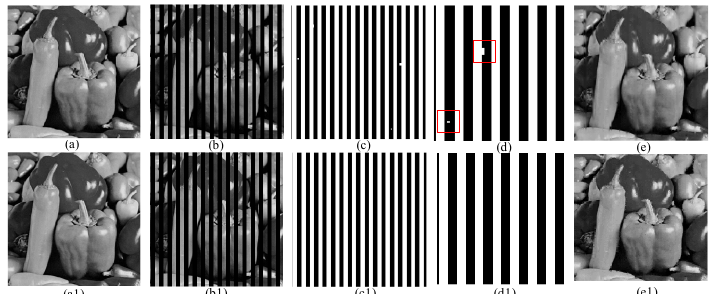
Figure 13. Longitudinal tampering distribution in Peppers (50% tampered): ( a ) Lee [1] watermarked image ( PSNR = 40.73 dB); ( b ) Lee tampered image; ( c , d ) Lee tamper detective image; ( e ) Lee recovered image ( PSNR = 27.42 dB); ( a1 ) proposed watermarked image ( PSNR = 40.76 dB); ( b1 ) proposed tampered image; ( c1 , d1 ) proposed tamper detective image; and ( e1 ) proposed recovered image ( PSNR = 29.71 dB).